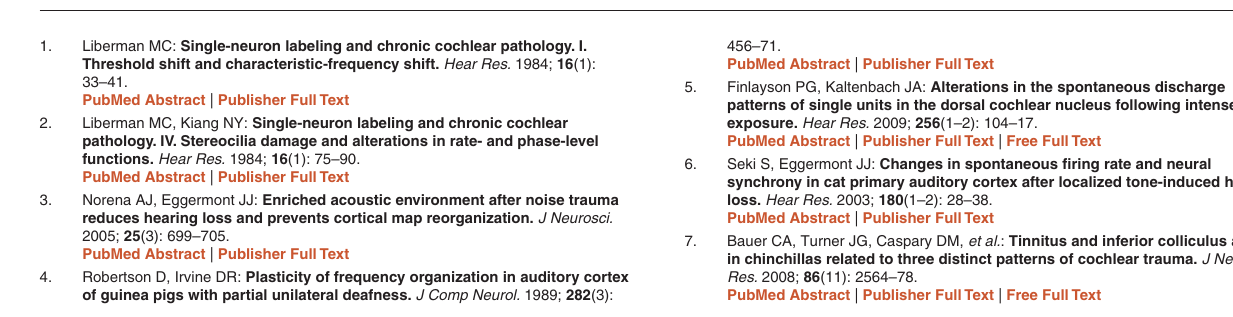
figshare : Data of paraflocculus cochlear trauma and modulation of gene expression. http://dx.doi.org/10.6084/m9.figshare.938193 44